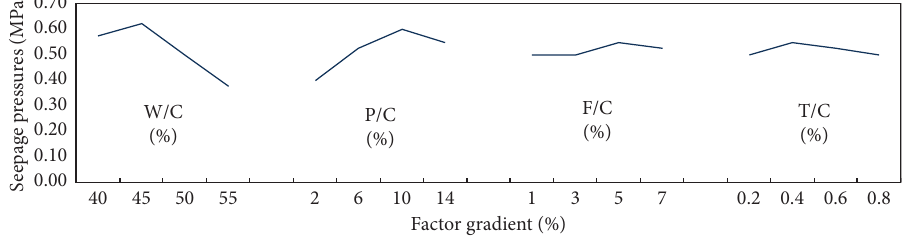
Figure 9: Osmotic pressure factor influence